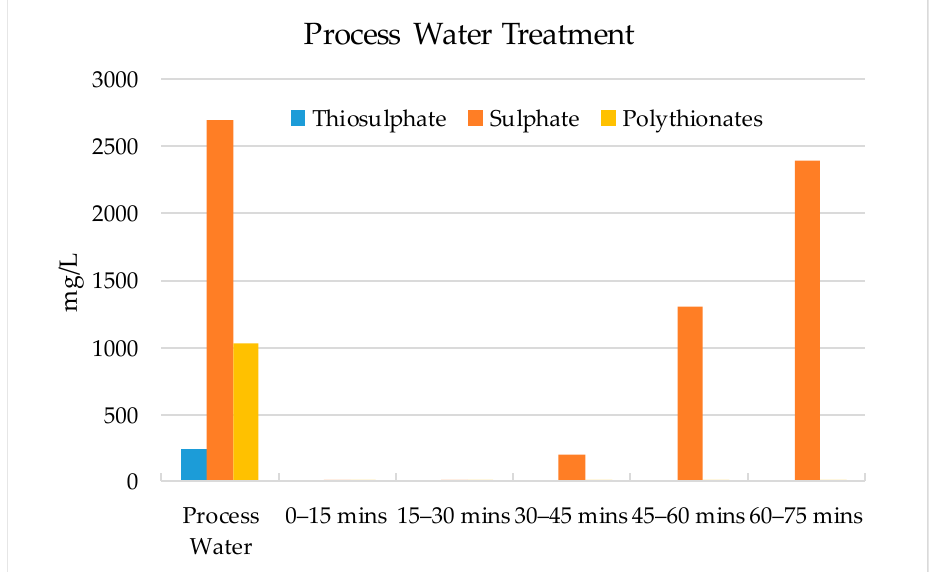
Figure 14. Desorption of sulphate ions from the resin in the regeneration stages applied after the adsorption experiments on the Thickener Overflow (O/F).